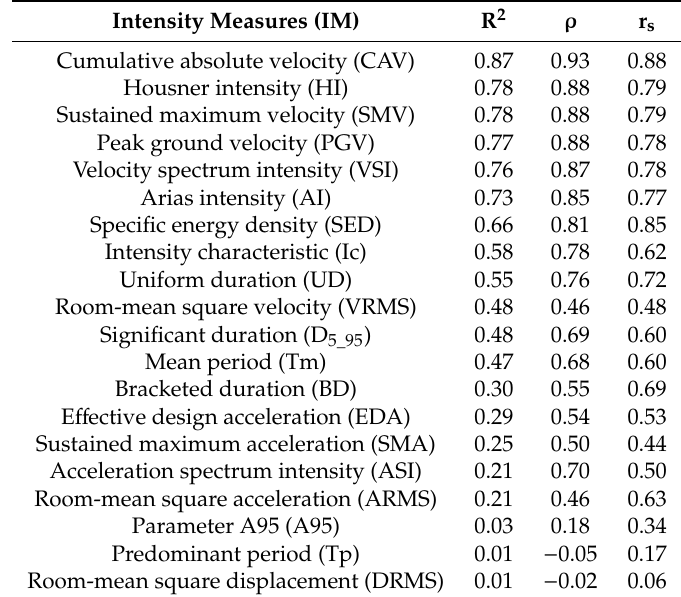
Table 9. Correlation between Intensity Measure (IM) and Lateral Displacement